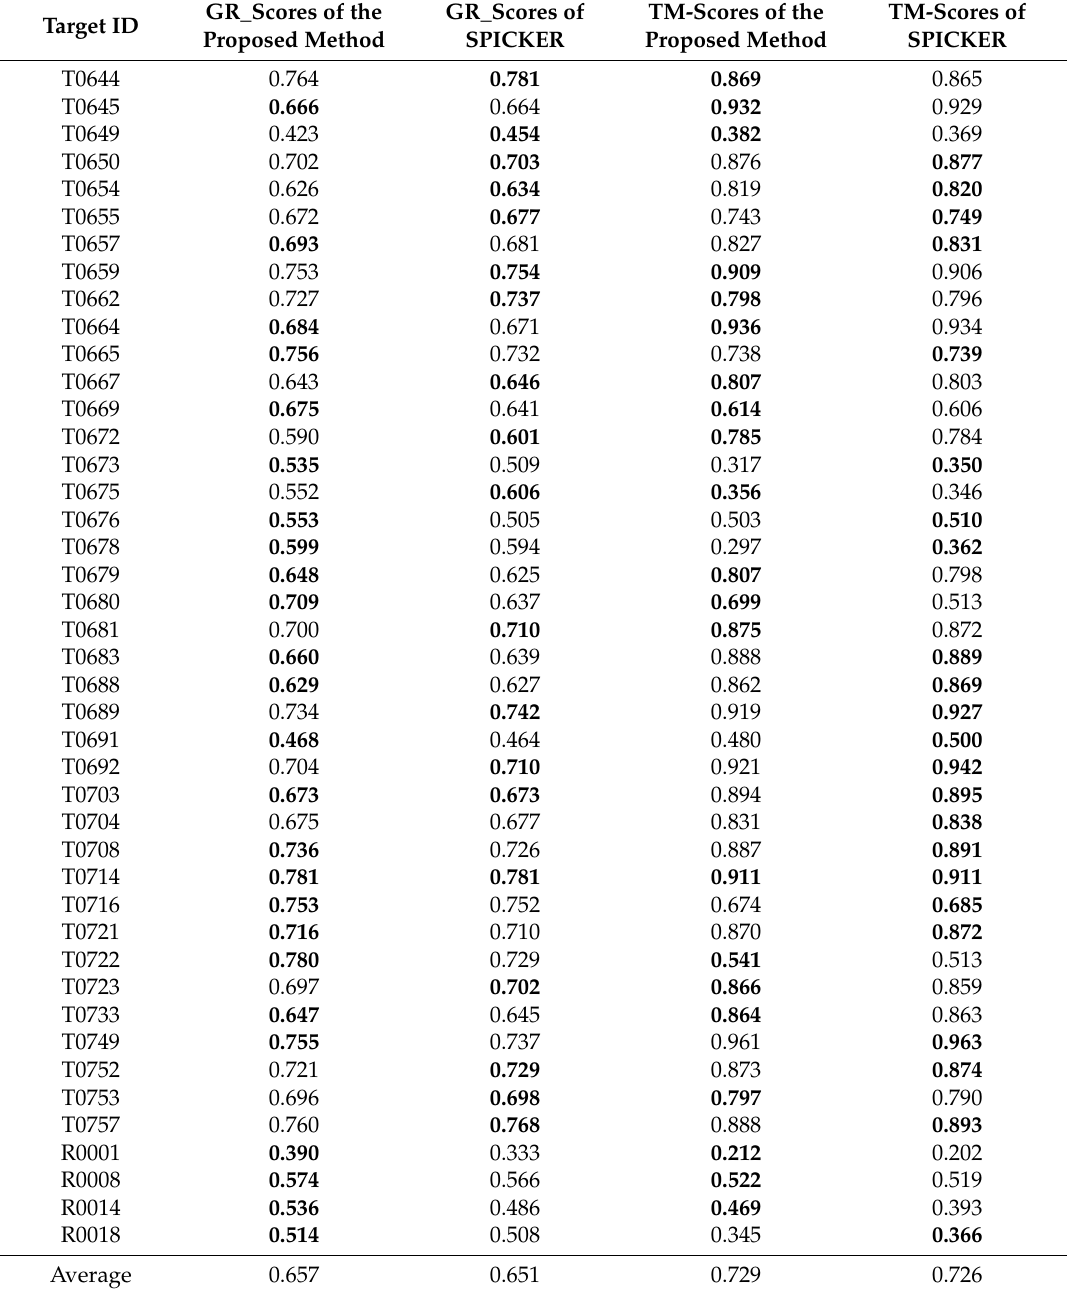
Table 1. The Comparison of GR_scores and TM-scores for datasets from CASP10. The bold number indicates the highest GR_score or TM-score for each